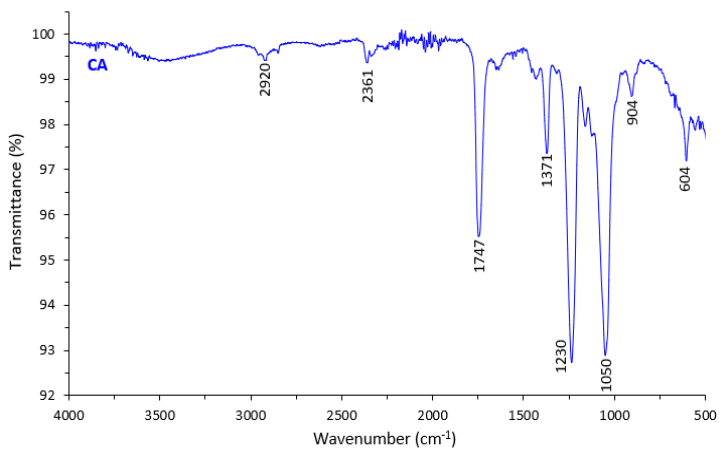
Figure 6. FT-IR spectra of the cellulose acetate membrane.